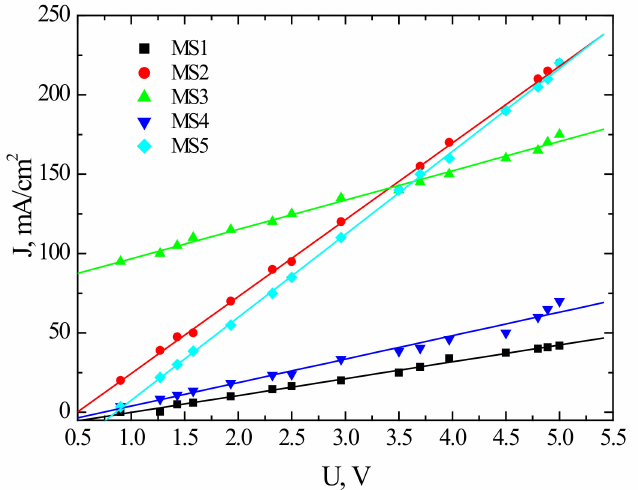
Figure 4. Photocurrent density versus voltage when films were formed by magnetron